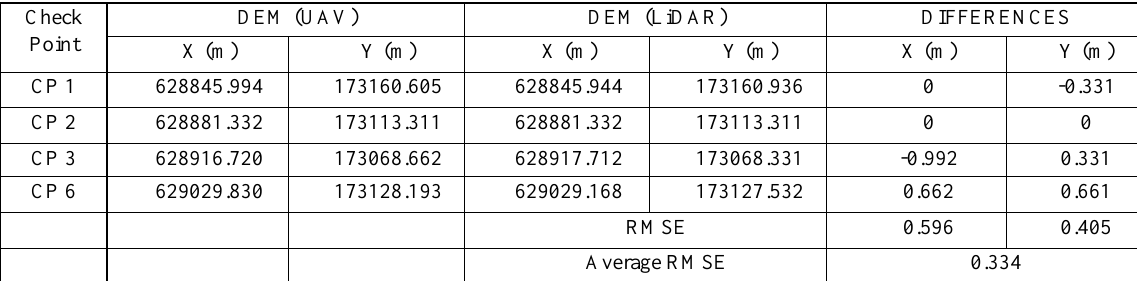
Table 7. Accuracy Assessment for DEM between UAV and LiDAR at 40m Altitude